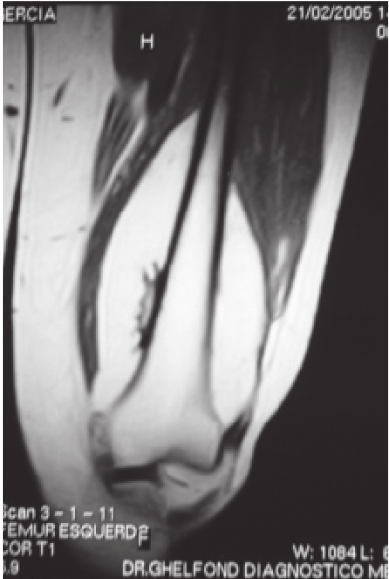
Figure 3 - Magnetic resonance image: coronal T1-weighted image where a solid expansion process can be noticed with hypersignal adjacent to the femur. Note the hyperostosis in the medial cortical bone with signal intensity similar to medullary intensity.